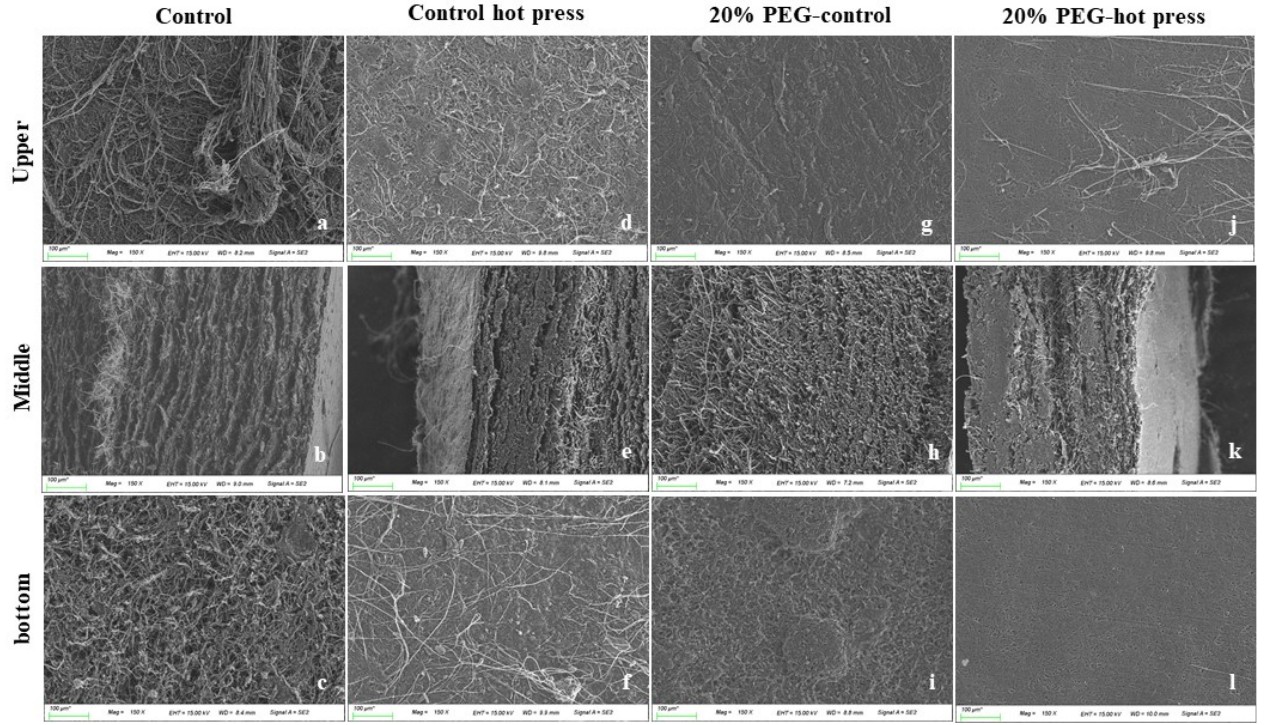
Figure 4. Scanning electron microscopy (SEM) images of MBLs. ( a – c ) control; ( d – f ) control hotpress; ( g – i ) 20% PEG control; ( j – l ) 20% PEG hotpress samples. Scale bars are marked with 100 μ m.